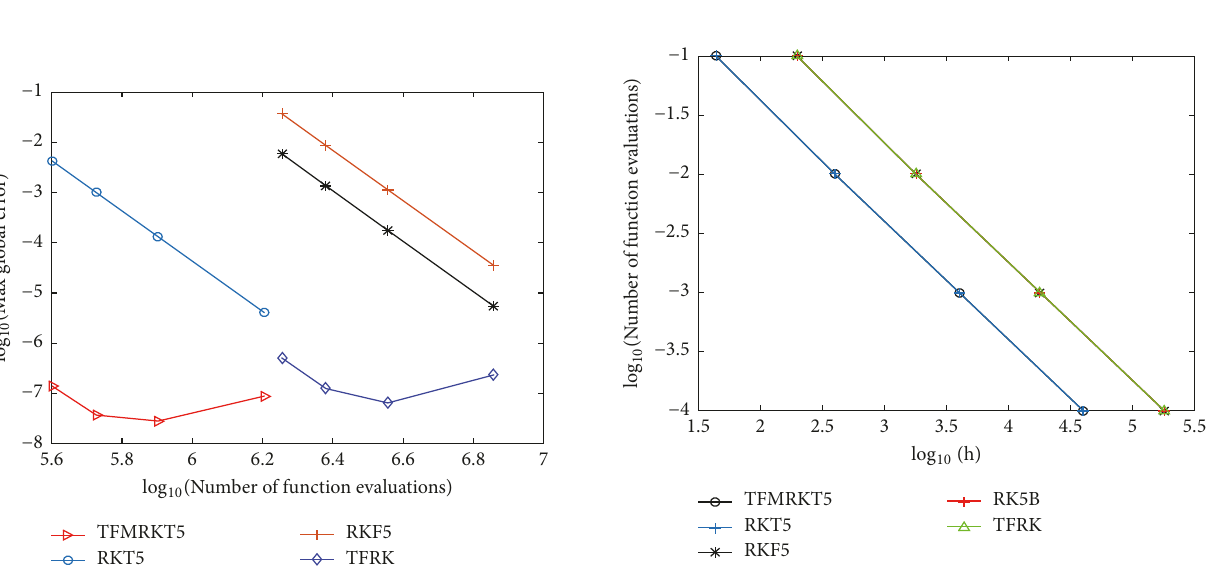
Figure 7: The efficiency curve for TFMRKT5, RKT5, RK5B, RKF5, and TFRK for Problem 8 with 𝑥 𝑒𝑛𝑑 = 10000 and ℎ = 0.025, 0.05, 0.075, 0.1 .